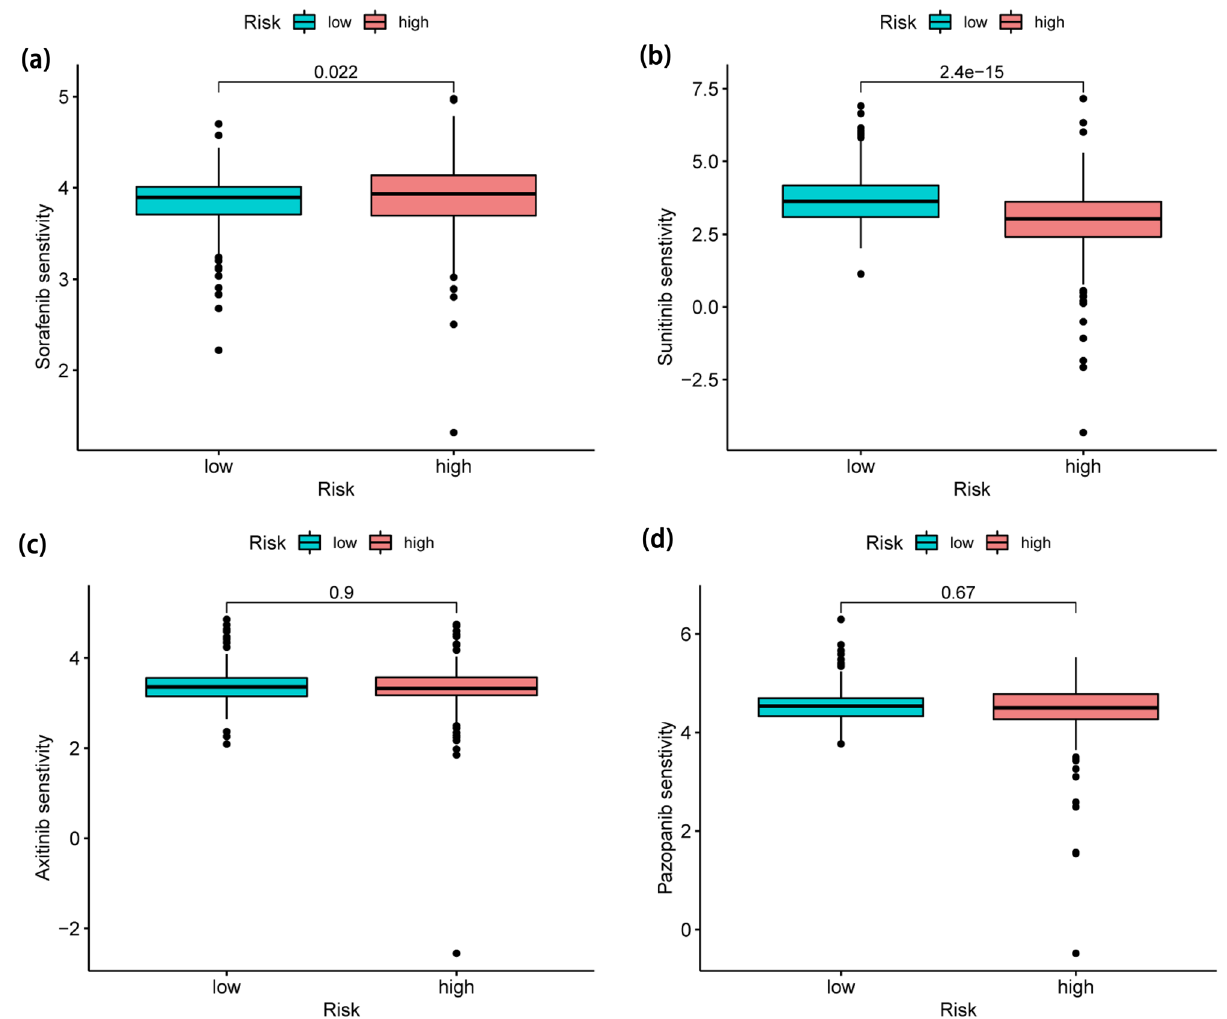
Figure 11. Differences in sensitivity of two groups to different drug responses. ( a ) Sorafenib (P = 0.022). ( b ) Sunitinib (P = 2.4e−15). ( c ) Axitinib (P = 0.9). ( d ) Pazopanib (P =